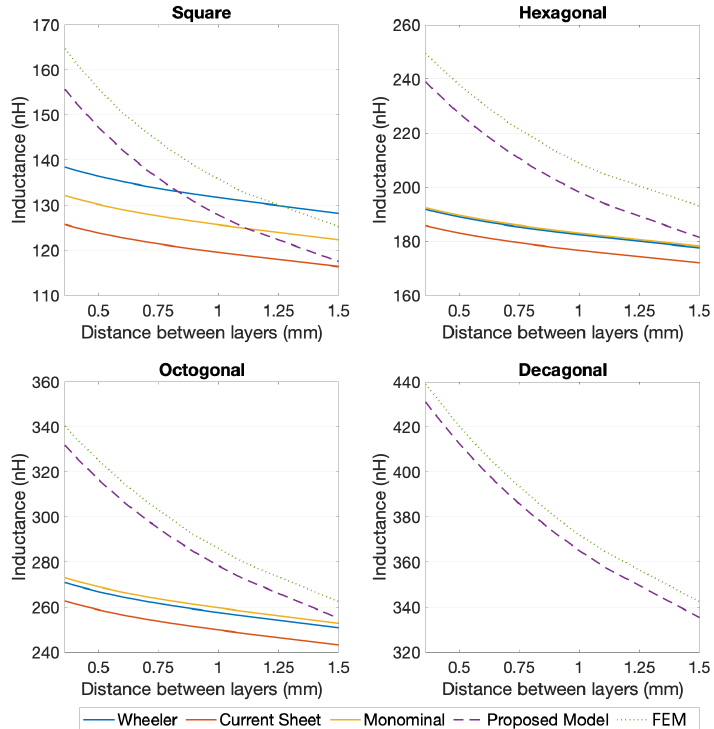
Figure 12. Comparison between several methods of inductance calculation of 2-layer coils with 4 turns, for L 0 = 1.3 mm, w = s = 0.15 mm, and for 4, 6, 8, and 10 segments per turn.